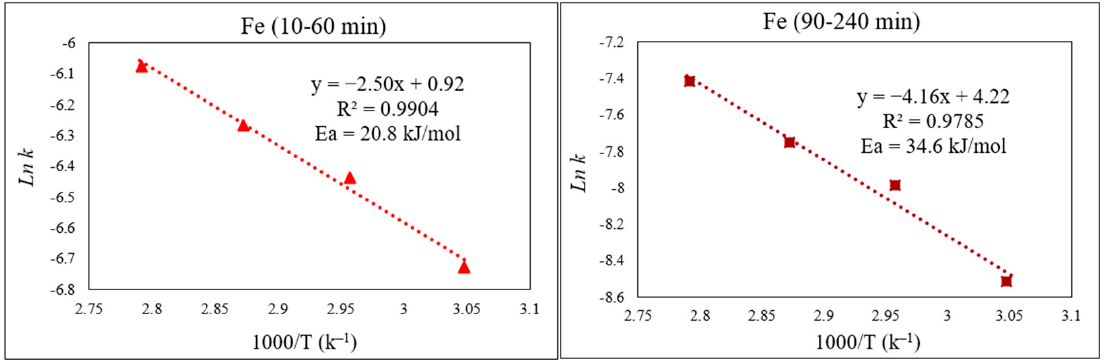
Figure 10. Arrhenius graph of ln k vs. 1000/T for the first part (10–60 min) and the second part (90–240 min) of Fe extraction.